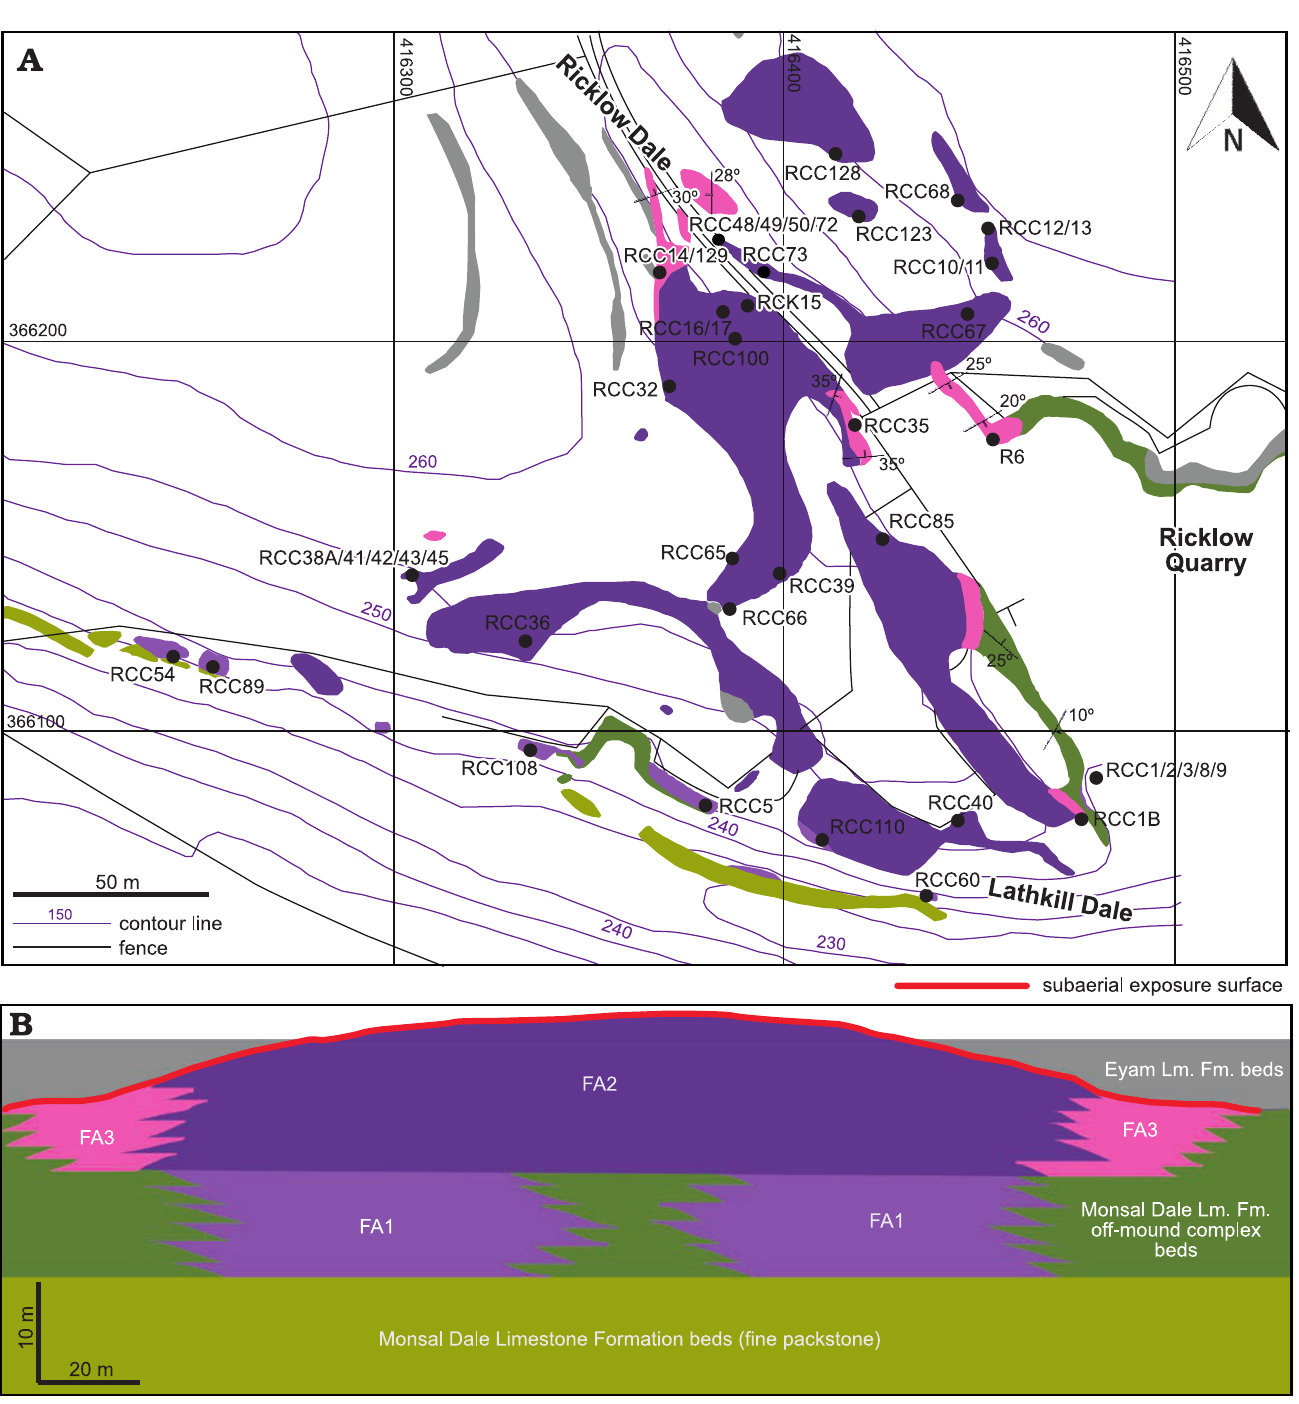
Fig. 3. Facies architecture of the Brigantian (uppermost Visean) mud mound complex of Ricklow Quarry. A . Facies association map (outcrops only) of the study area of Ricklow Quarry, with position of the collected fossil brachiopod assemblages and samples for thin sections. Map drawn from a geodata- base built with ESRI ArcGIS® software. Basemap by Ordnance Survey, OS MasterMap Topography Layer, 1:1250 series. Kilometric coordinate system: British National Grid (projection: Transverse Mercator; datum: OSGB 1936; units: metres). B . Interpretative stratigraphic scheme of the studied mud mound complex with spatial distribution of the distinguished facies associations. Scales are approximate with 2× vertical exaggeration. Flank beds are inclined with an angle of 20–44°. Abbreviations: Fm., Formation; Lm.,